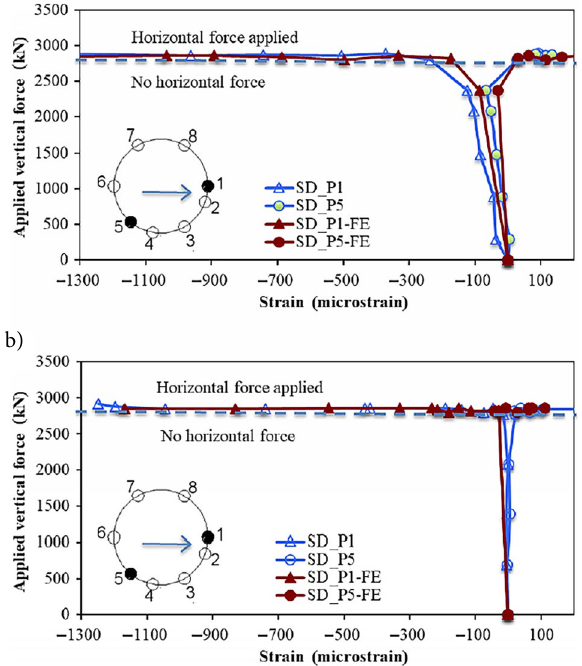
Figure 9. Normal stress versus applied horizontal applied